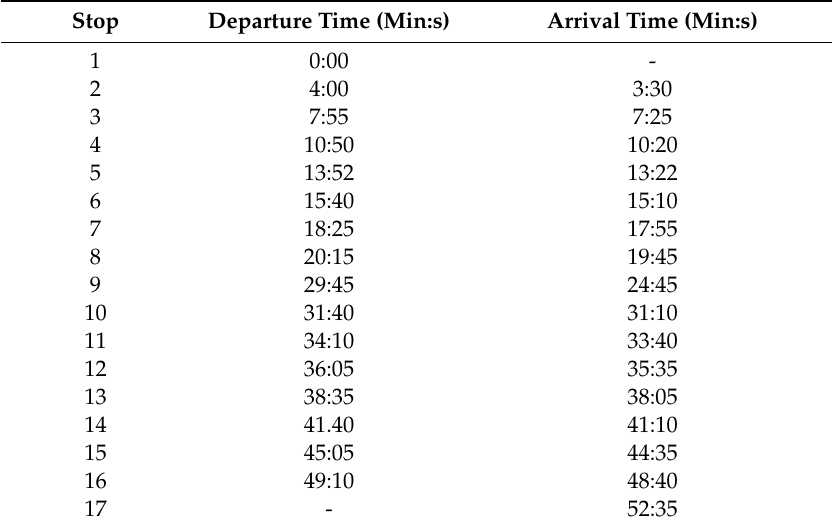
Table 4. Journey